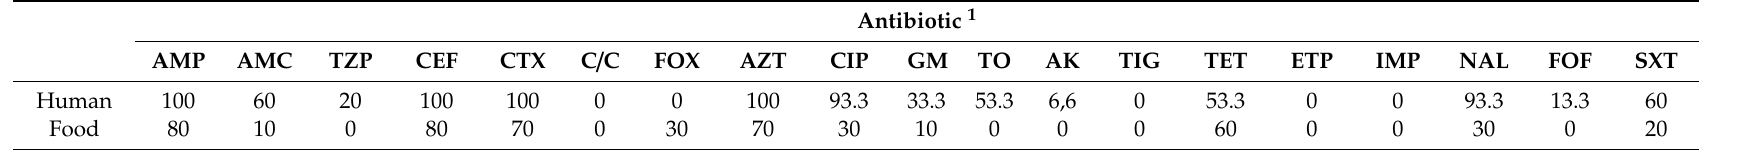
Table 2. Percentages of resistance against di ff erent antimicrobials from each isolate